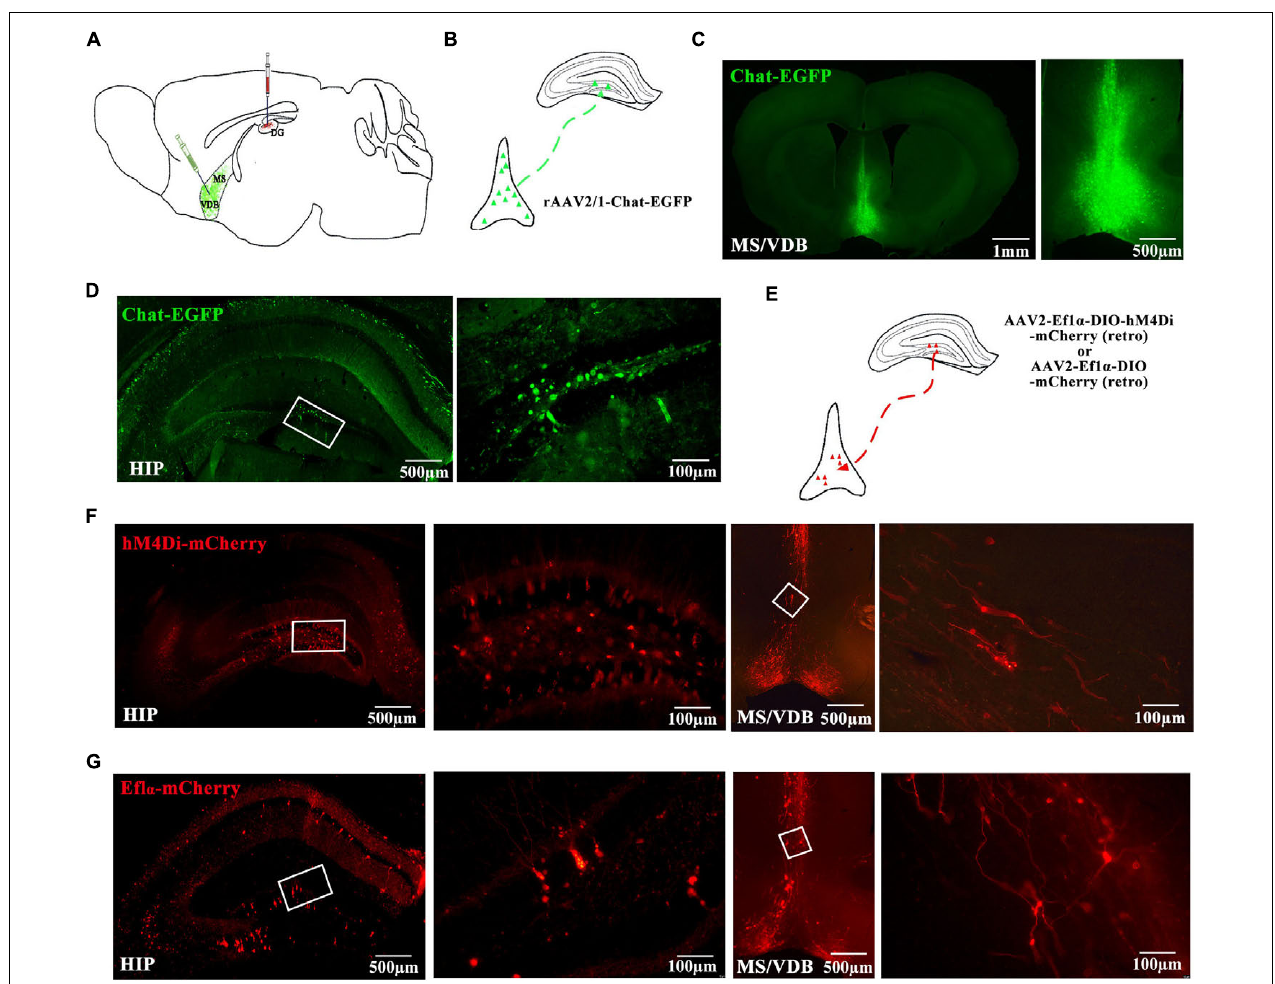
FIGURE 9 | The MS/VDB-DG cholinergic neural circuit projections and hM4Di receptor expression. (A) Schematic of the virus injections in the MS/VDB and DG. (B) Schematic of the monosynaptic anterograde tracing strategy shows the rAAV2/1-chat-EGFP virus in MS/VDB for labeling ChAT neurons. (C,D) Representative images of the basal forebrain (Left) (scale bar = 1 mm) and hippocampus (Left) (scale bar = 500 µ m). photomicrographs of MS/VDB (Right) (scale bar = 500 µ m) and DG (Right) (scale bar = 100 µ m). (E) Schematic of the monosynaptic retrograde tracing strategy shows the application of AAV2-Ef1 α -DIO-hM4D(Gi)-mCherry or AAV2-Ef1 α -DIO-mCherry virus in DG. (F,G) Chemogenetic inhibition of the MS/VDB-DG cholinergic neural circuit and representative image of the hM4Di-mCherry expression in the DG (Left) and MS/VDB (Right). Ef1 α -mCherry set as control. The white frame indicates 200 ×